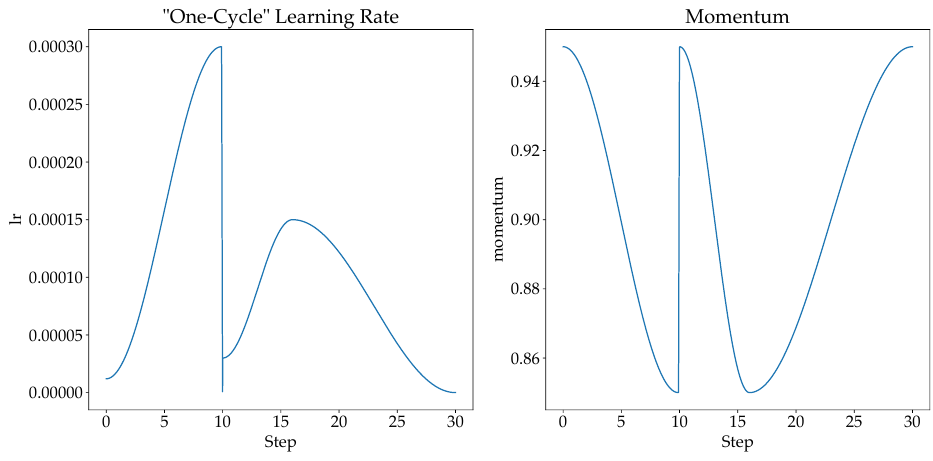
Figure 5. The learning rate and momentum for cosine annealing for our proposed model. For the first 10 epochs (training of newly added head classifier), the learning rate is scheduled with a cosine annealing from 4 × 10 − 6 to 1 × 10 − 4 , with momentum for cosine annealing between 0.95 to